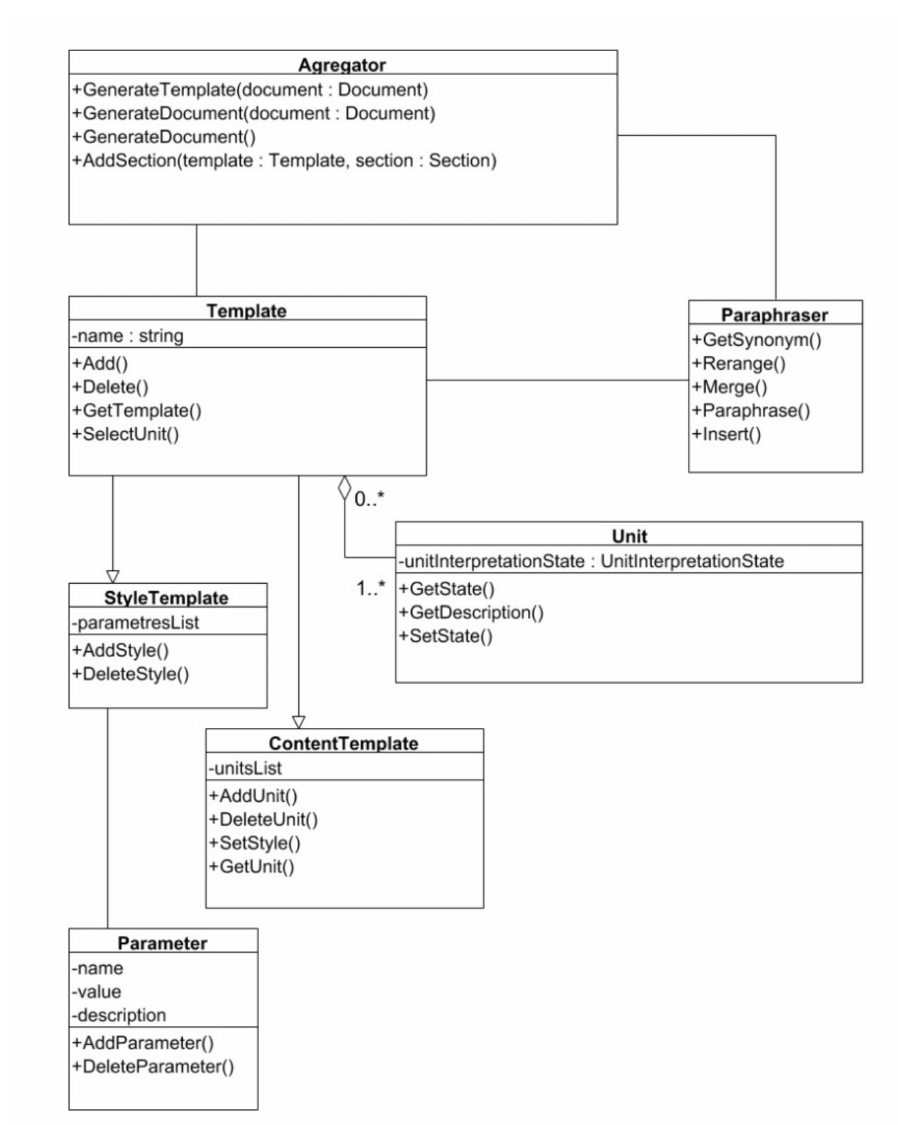
Figure 5. Text generation